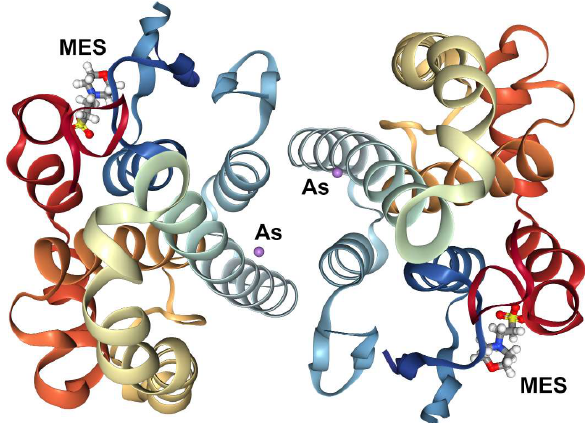
Figure 1. Crystal structure of human glutathione transferase pi complexed with a metalloid in the absence of glutathione, PDB ID: 5DAK: molecule: glutathione S-transferase P (chain: A, B), heteroatoms CSO (S-hydroxycysteine), MES (2-(n-morpholino)-ethanesulfonic acid) and As (arsenic).